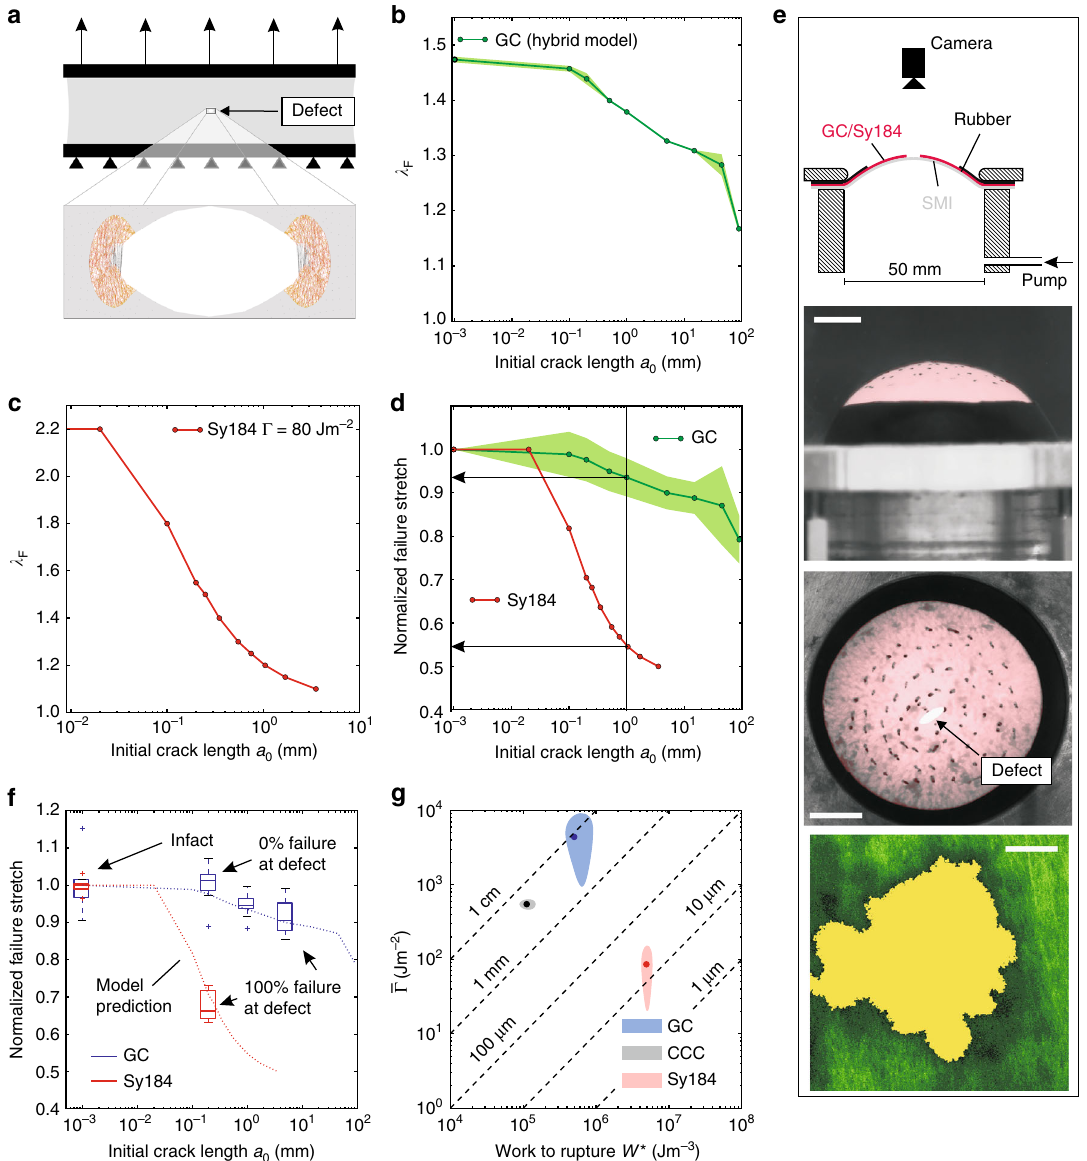
Fig. 3 Defect tolerance of SCT and elastomers. a Biaxial tests of SCT containing a small defect: the simulated load case is illustrated, with the discrete fi ber network model in the near fi eld of the defect. b Results of the corresponding in-silico study for GC ( n = 3), represented as mean and standard deviation. The computed global failure stretch λ F is shown for different defect sizes. c The reduction of λ F as a consequence of defects in an elastomer (Sy184) from fracture mechanics-based simulations using Γ = 80 J m − 2 42 . d Sy184 (in red) and GC (in green) simulations are compared using the normalized λ F with respect to the critical elongation of intact samples. e Experimental setup of the in fl ation experiments, where λ F for defects of 0.2 mm, 1 mm and 5 mm ( n = 10 for each defect size) is determined. Leakage is prevented by a layer of soft elastomer material. Representative top and side images for GC are shown and a 5 mm crack is indicated (scale bar: 10 mm). Black ink markers are visible on the tissue surface which were applied to facilitate measurement of deformations (see Methods). A MPM image documents the shape of a small defect with nominal length of 0.2 mm (defect in yellow, scale bar: 100 μ m). f Experimental results for GC (in blue) and Sy184 (in red) for λ F normalized with respect to the critical elongation in uniaxial tension ( n = 5 each) experiments. The trendline from simulation (dotted red and blue) is indicated and experimental data are reported in boxplots, where boxes represent upper and lower quartiles and lines inside the boxes de fi ne the median, while dots represent outliers, and whiskers 10 – 90 percentiles. g Experimental results for the material tearing energy Γ (Sy184 from ref. 42 ) and the work to rupture W *24 in uniaxial tensile ( n = 5 each) experiments, represented with mean